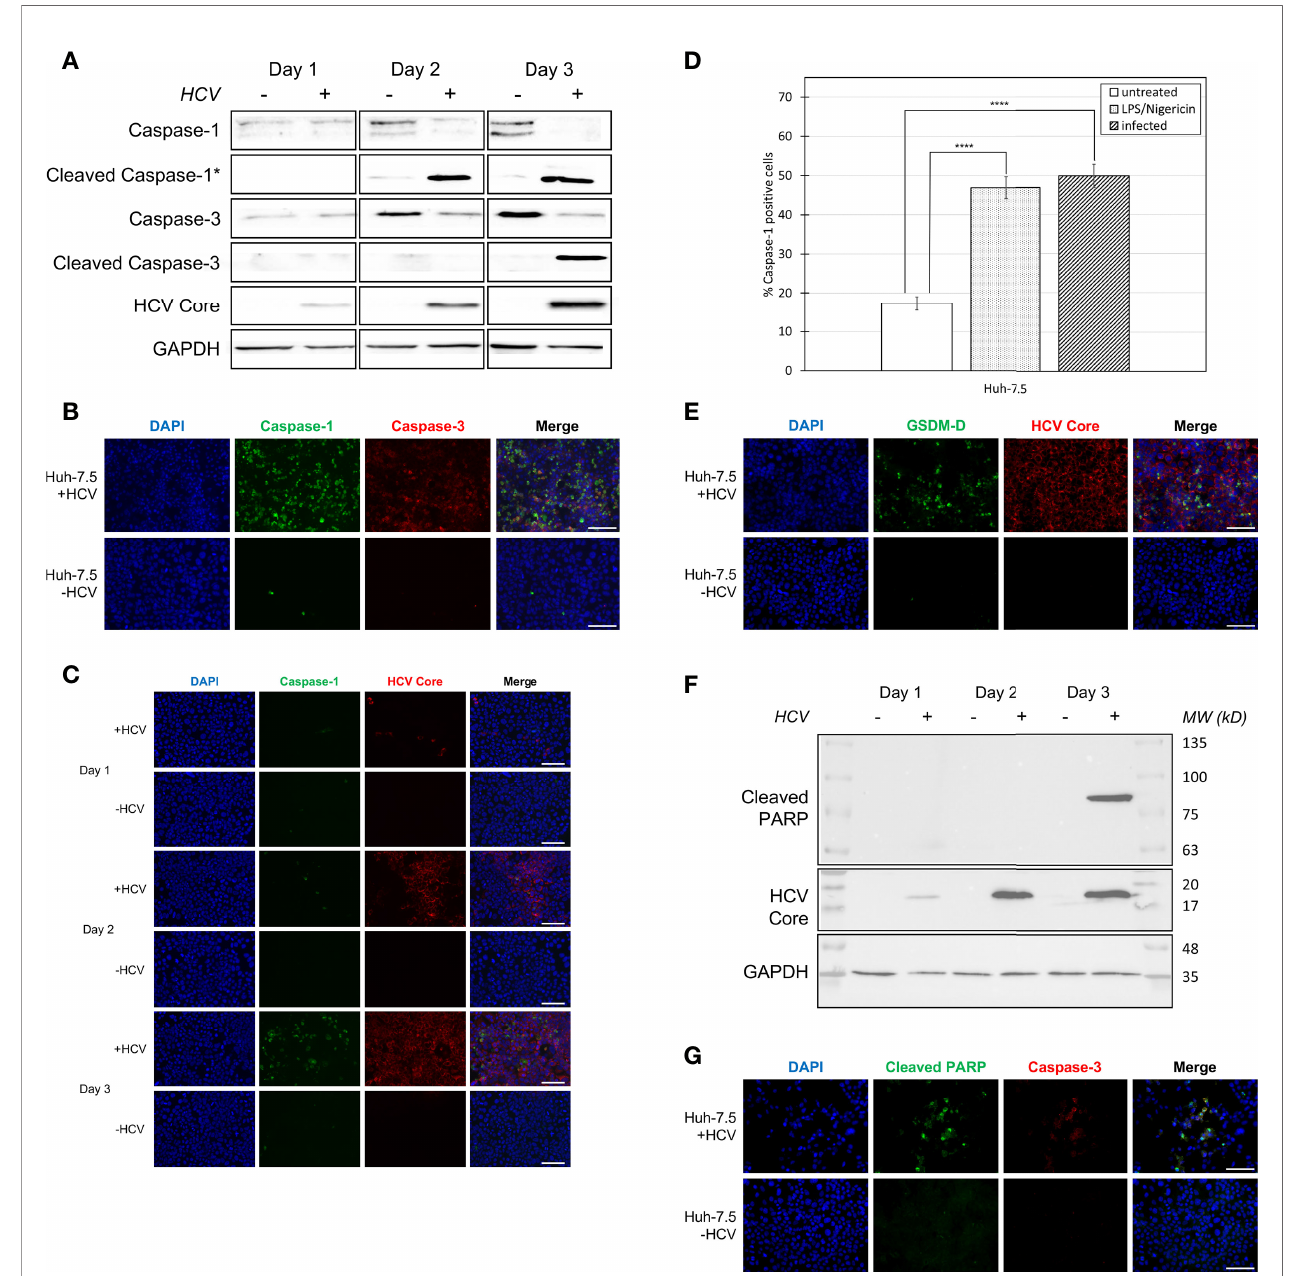
FIGURE 1 | Activation of pyroptosis- and apoptosis-associated proteins during HCV infection. Huh-7.5 cells were infected with HCV at MOI = 1 or left uninfected. (A) At 1, 2, and 3 days p.i., cells and culture fl uids were harvested for Western Blot analysis. Membranes were probed for pro-caspase-1, cleaved-caspase-1, pro- caspase-3, cleaved-caspase-3, HCV core protein, and GAPDH. * indicates samples from cell culture fl uids rather than cell lysates. (B) At 3 days p.i., cells were stained for cleaved caspase-1 (green) using a speci fi c probe, then fi xed using acetone. Cells were subsequently stained using antibodies speci fi c for cleaved caspase-3 (red). Scale bar, 100 m m (C) At 1, 2, and 3 days p.i., cells were stained for cleaved caspase-1 using the same speci fi c probe (green) then fi xed using acetone. Cells were subsequently stained using an antibody speci fi c for HCV core protein (red). (B, C) Nuclei were stained with DAPI (blue) and analysis was performed using fl uorescent microscopy. Scale bar, 100 m m (D) At day 4 p.i., cells were stained for cleaved caspase-1 using a speci fi c probe and fi xed using fi xative from the caspase-1 probe kit. Cells were run on a CytoFLEX fl ow cytometer and data were analyzed using Kaluza analysis software. Data are presented as the percent of total cells that were positive for caspase-1. ****p < 0.0001. (E) At 3 days p.i., cells were fi xed using acetone and stained for cleaved GSDM-D (green) and HCV core protein (red) using speci fi c antibodies. Scale bar, 100 m m (F) At 1, 2, and 3 days p.i., cells were harvested for Western Blot analysis. Membranes were probed for cleaved PARP, HCV core protein, and GAPDH. (G) At 3 days p.i., cells were fi xed using acetone and stained for cleaved PARP (green) and cleaved caspase-3 (red) using speci fi c antibodies. Scale bar, 100 m m (A – G) Data are representative of three independent